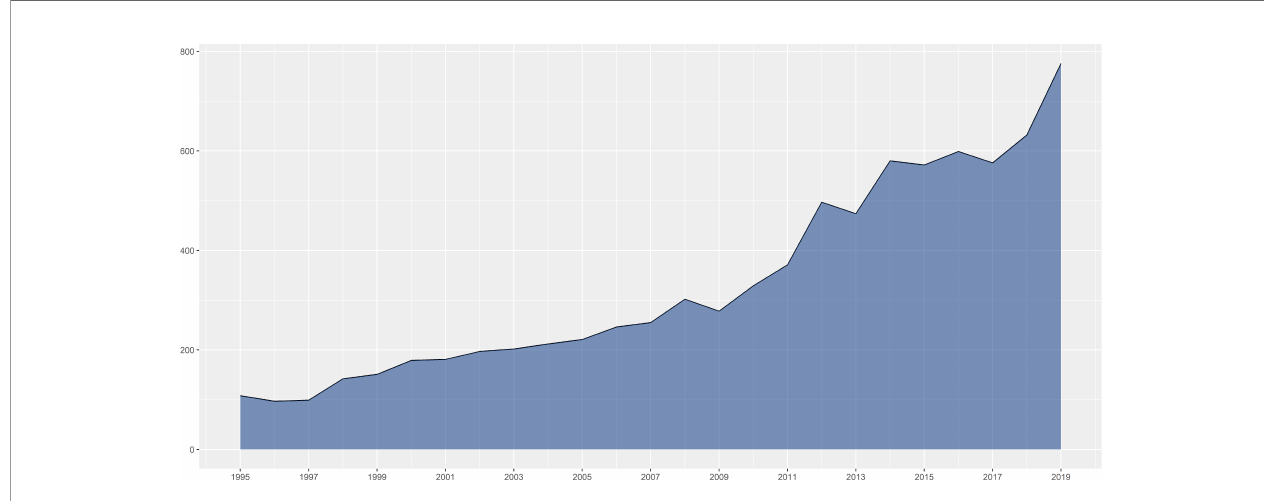
FIGURE 1 | Scienti fi c publications per